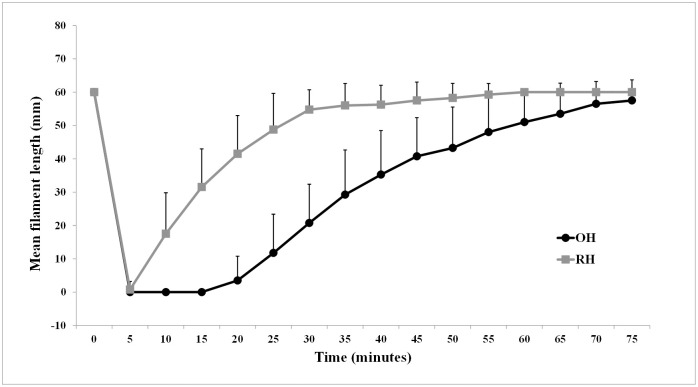
Comparison of mean corneal touch threshold (CTT) values in mm filament length (± standard deviation) obtained at baseline and at 5-minute intervals thereafter, for a total of 75 minutes following application of topical 0.4% oxybuprocaine hydrochloride ophthalmic solution (OH) and 1% ropivacaine hydrochloride (RH) in clinically healthy rats.The CTT in mm is further converted to pressure in grams per mm2 and in milligrams per S (S = 0.0113 mm2 sectional area of the filament), according to the conversion table provided by the manufacturer.